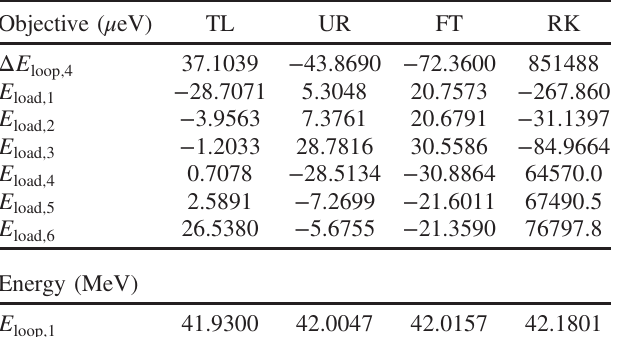
varied include all N phases, N voltages, and M lengths in the system; output functions are the objectives